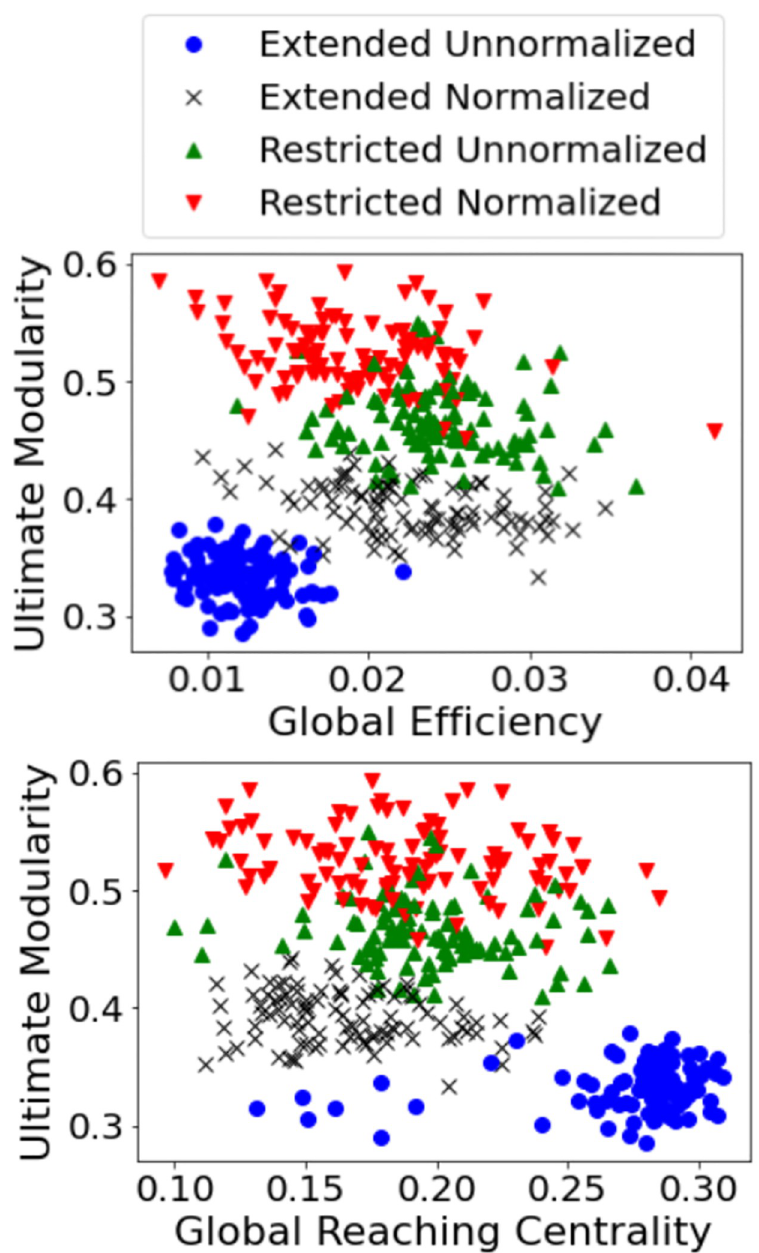
Fig 7. (a)(top) The balance between integration and segregation in all types of connectomes; (b)(bottom) segregation vs. hierarchy in all types of